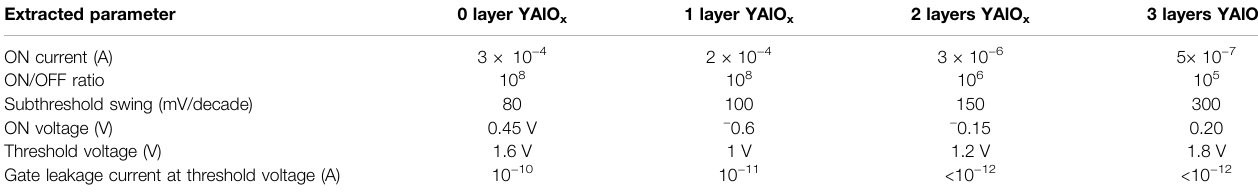
TABLE 3 | Device parameters of the TFTs with bilayer dielectric layers. Extracted parameter